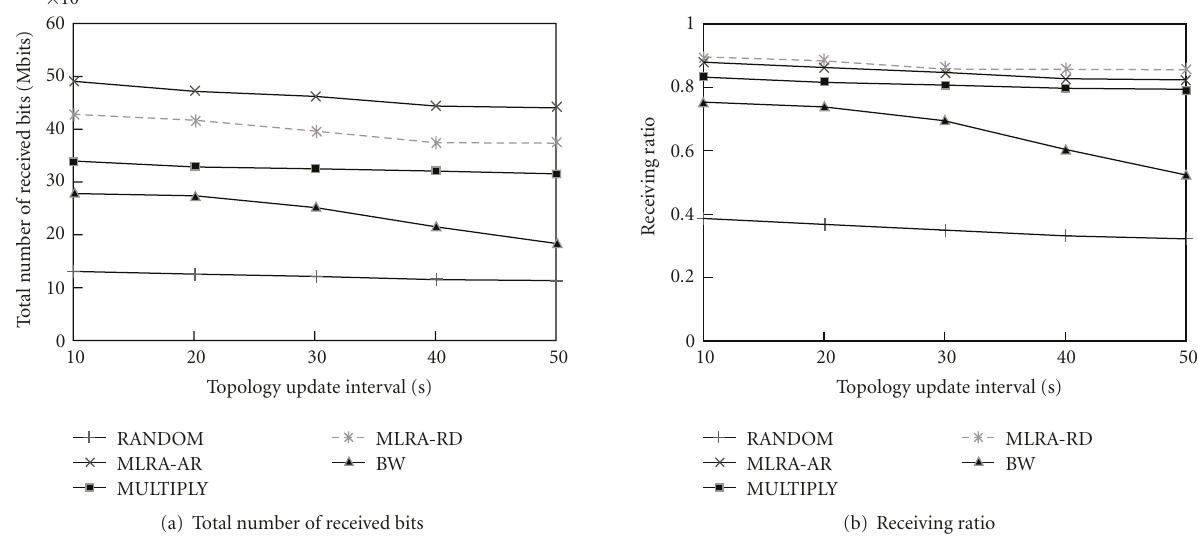
Figure 4: Performance versus topology update interval in mTreebone with varying topology update interval. Other parameters are listed in